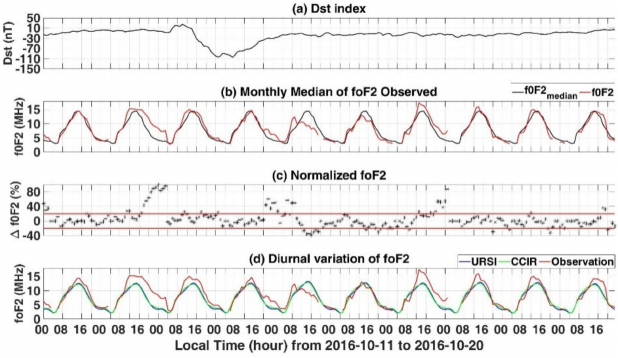
Figure 4. Diurnal variation of fo F2 from ionosonde observations, and the IRI-2016 with the URSI and CCIR options during a geomagnetic